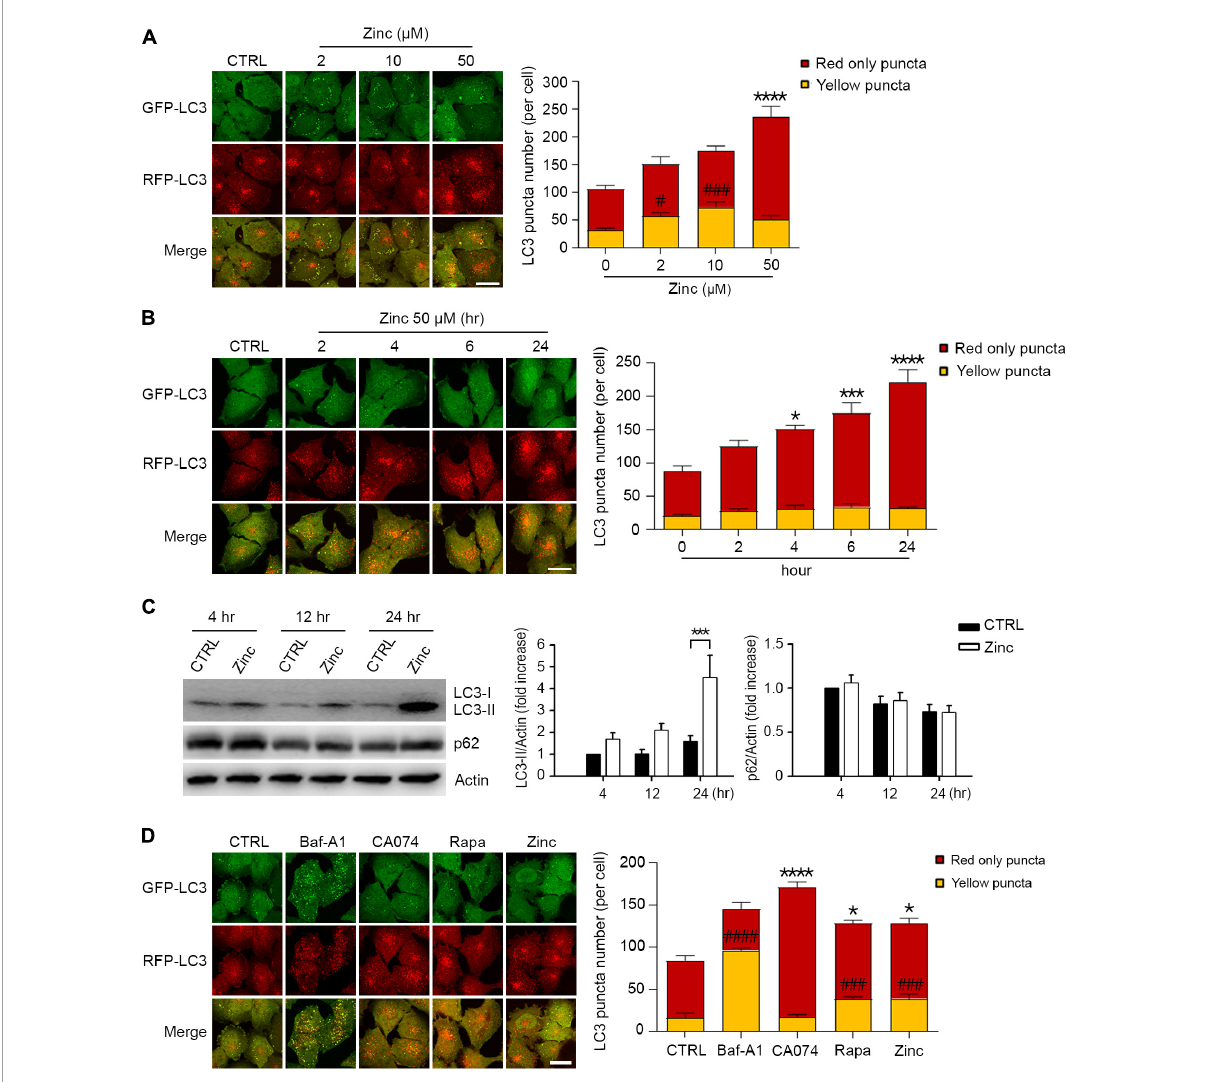
FIGURE1 Zinc activates autophagic flux. (A) Fluorescence confocal microscopy images of H4 glioma cells expressing mRFP-GFP-LC3 (mRGL-H4 cells) 24 h after exposure to the indicated concentrations of ZnCl 2 (Zinc). The bar graph (right) represents the quantitative analysis of the number of red-only or yellow puncta per cell (mean ± SEM, n = 17 different fields taken from ≥ 3 independent biological replicate experiments). Scale bar 20 µ m. **** p < 0.0001 for red-only puncta, and # p < 0.05 or ### p < 0.001 for yellow puncta by ANOVA with post hoc Dunnett’s test. (B) Fluorescence confocal microscopy images of mRGL-H4 cells at the indicated time points after exposure to 50 µ M ZnCl 2 (Zinc). The bar graph (right) represents the quantitative analysis of the number of red-only or yellow puncta per cell (mean ± SEM, n = 10 different fields taken from ≥ 3 independent biological replicate experiments). Scale bar 20 µ m. * p < 0.05, *** p < 0.001, or **** p < 0.0001 for red-only puncta by ANOVA with post hoc Dunnett’s test. (C) Western blot analysis for LC3 and p62 in mRGL-H4 cells. Protein samples were prepared at the indicated time points after exposure to sham wash (CTRL) or 50 µ M ZnCl 2 (Zinc). Actin was used as the loading control. Quantification of LC3-II conversion and p62 expression at the indicated time points was made in ≥ 3 independent biological replicate experiments. *** p < 0.001 by ANOVA with post hoc Dunnett’s test. (D) Fluorescence confocal microscopy images of mRGL-H4 cells 12 h after sham wash (CTRL), or exposure to 100 nM bafilomycin A1 (Baf-A1), 10 µ M CA074-ME (CA074), 100 nM rapamycin (Rapa), or 50 µ M ZnCl 2 (Zinc). Quantification of the number of red-only or yellow puncta per cell (mean ± SEM, n = 15 different fields taken from ≥ 3 independent biological replicate experiments) was shown as right bar graph. Scale bar 20 µ m. * p < 0.05 or **** p < 0.0001 for red-only puncta, and ### p < 0.001 or #### p < 0.0001 for yellow puncta by ANOVA with post hoc Dunnett’s